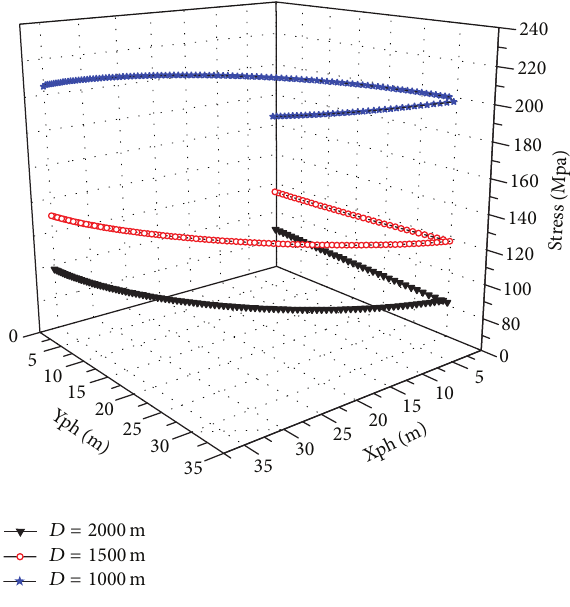
Figure 11: Maximum stresses in different 𝐷 .